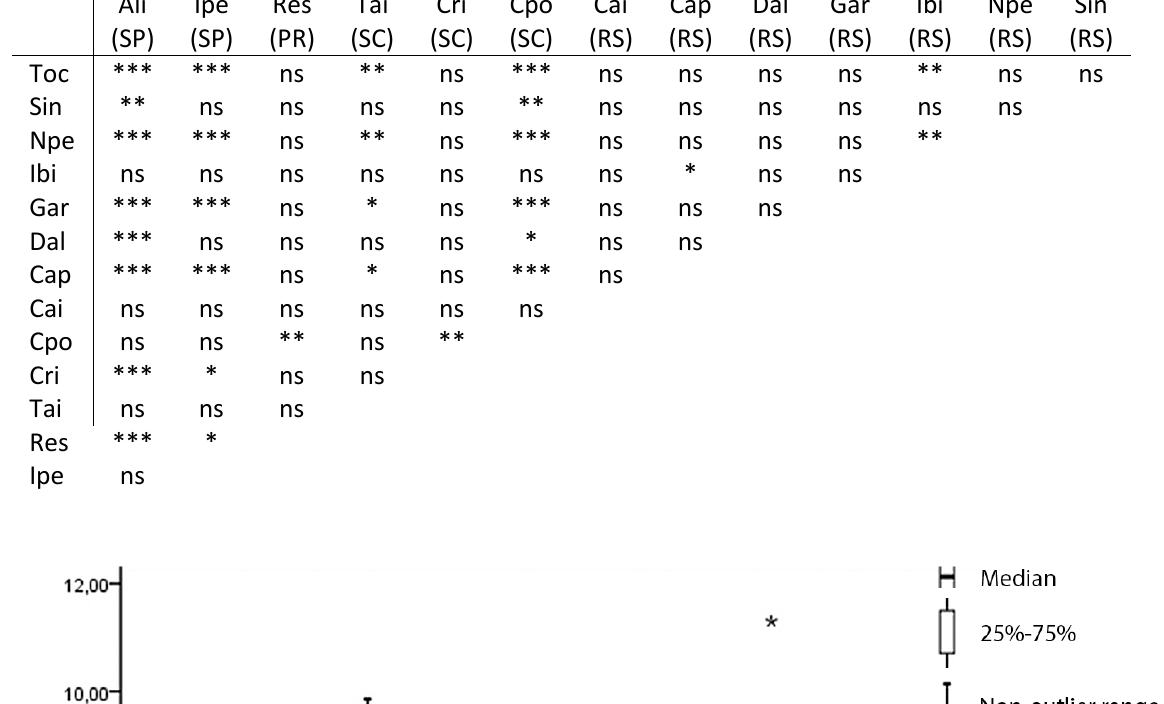
Table 3: Results from Bonferroni post hoc test for centroid size. * = p<0.05, ** = p<0.01, *** = p<0.001, ns = not significant.